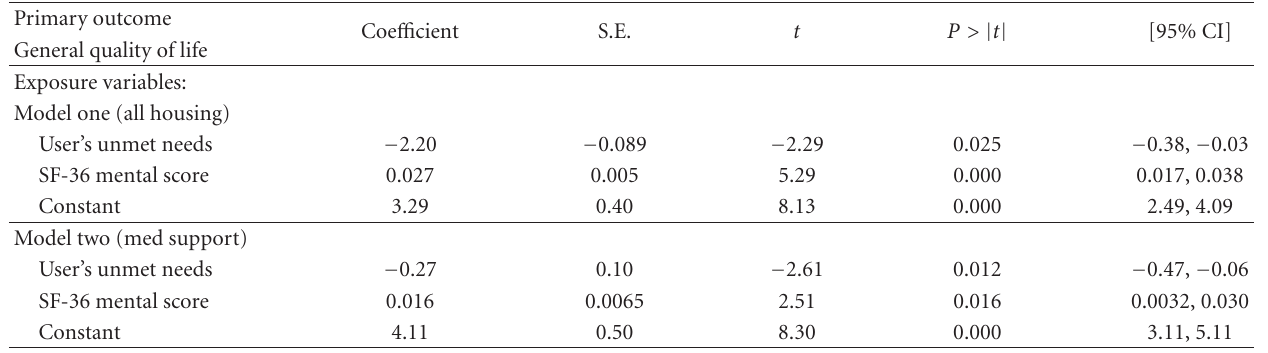
Table 5: Significant models following multiple regression analysis with general quality of life as the primary outcome. Primary outcome Coe ffi cient S.E. P > | t | [95% CI] General quality of